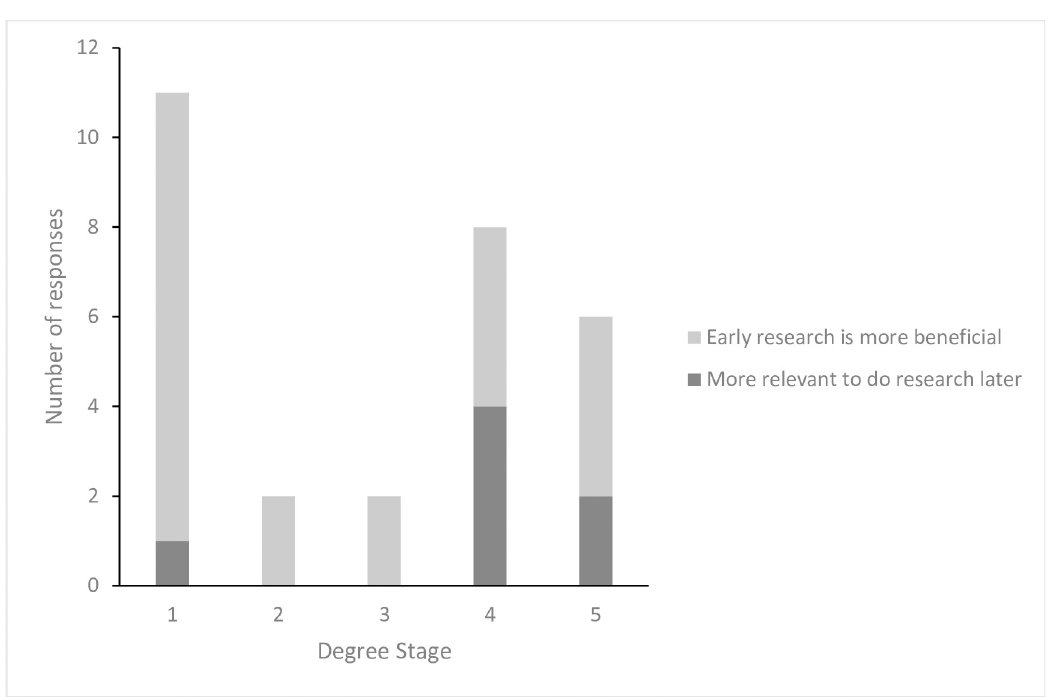
Fig 3. Bar chart showing the number of coded responses discussed during the focus group that were associated with the timing of research experiences. Each of the five stages of undergraduate medicine is represented individually, to facilitate an understanding of when research experiences are considered most appropriate. Students largely believed that research opportunities should be available early in the curriculum, although some later-stage students perceived that their enhanced understanding of curricular content would mean later research experiences would be more